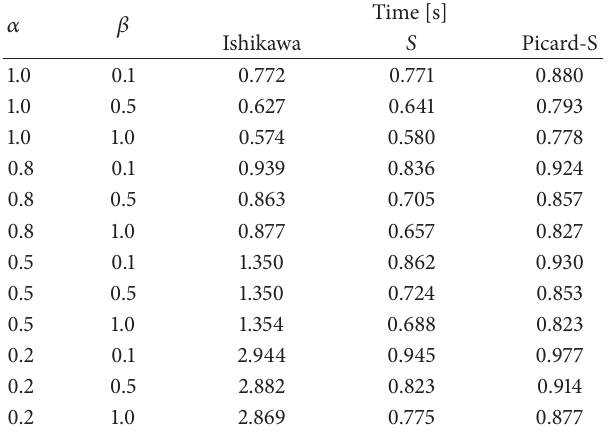
Table 5: Times of polynomiograph’s generation for 𝑝 2 using two parameters iterations.